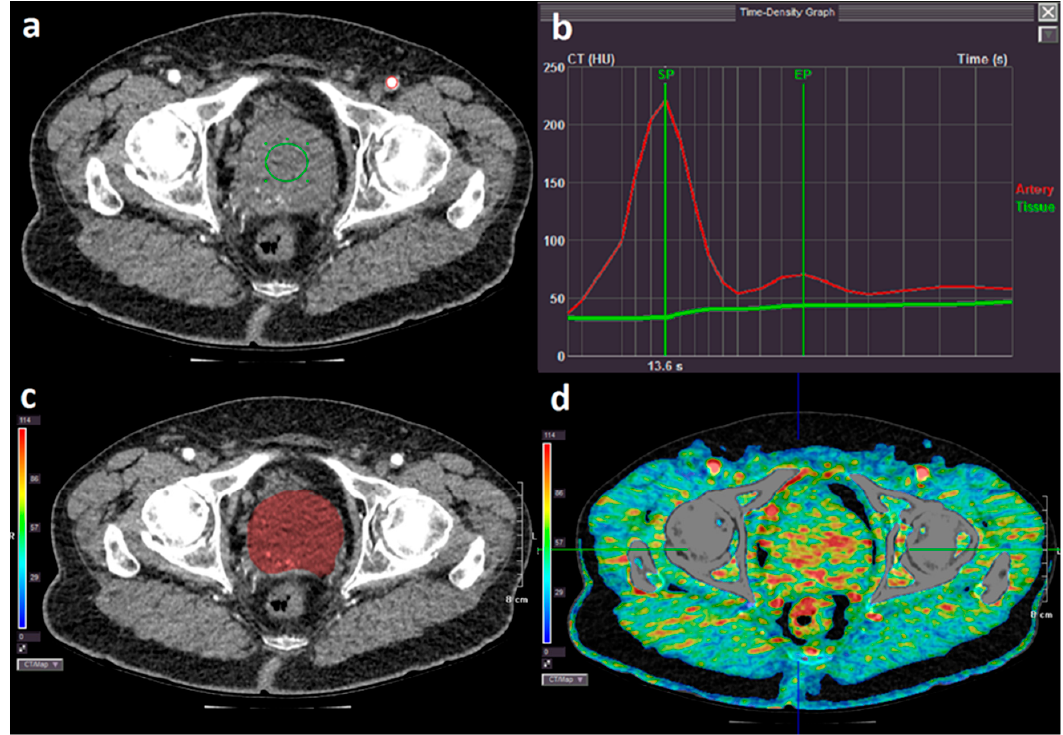
Figure 1. ( a ) 50 mm 2 and 600 mm 2 region of interest (ROI) was placed in the left femoral artery (red circle) and centrally in the prostate (green circle) to obtain the arterial and tissue input function, respectively; ( b ) time-density graph showing arterial (red line) and tissue (green line) contrast medium attenuation. The green vertical lines mark the start point (SP) and end point (EP) for perfusion measurements; ( c ) contour of the prostate was outlined manually using the sculpting tool (red area); ( d ) colorimetric map of blood flow.